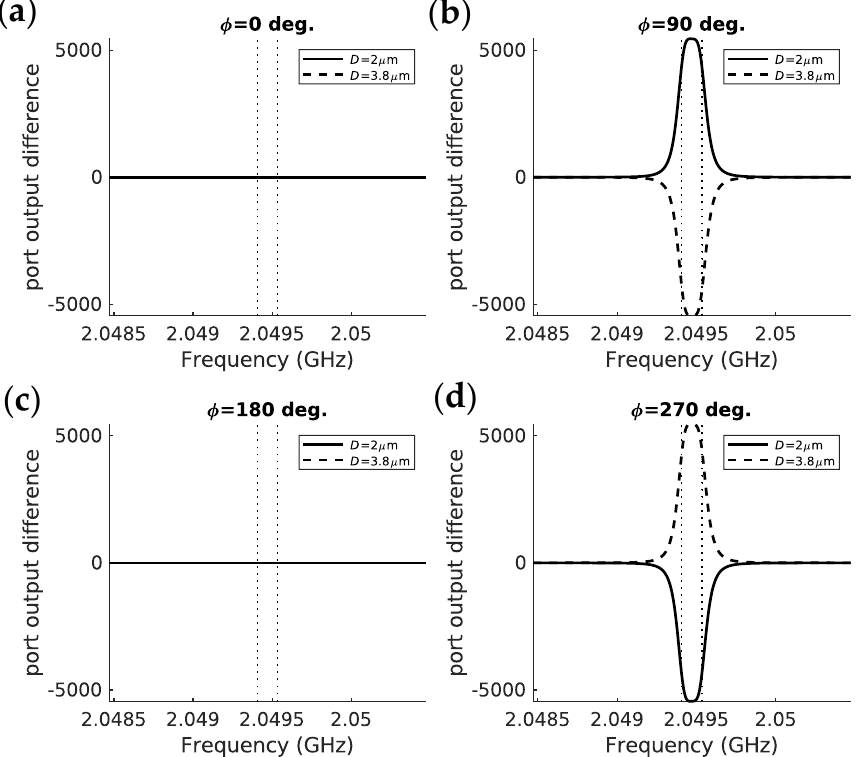
Figure 10. Difference between the output ports P 1 and P 2 in shape B with D = 2 µ m (solid lines) and 3.8 µ m (dashed lines) under the excitation of two sources at four fixed temporal phase shifts ( a–d ).